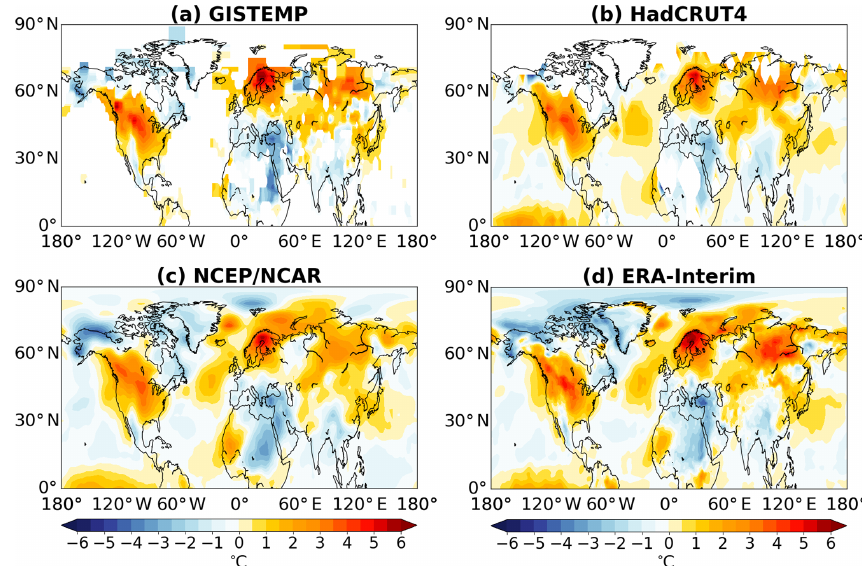
Figure 1. Surface air temperature anomalies ( ◦ C) for the post-Pinatubo winter of 1991–1992 relative to the reference period (1985–1990) in observations (a) GISTEMP and (b) HadCRUT4 and in reanalyses (c) NCEP/NCAR and (d) ERA-Interim.